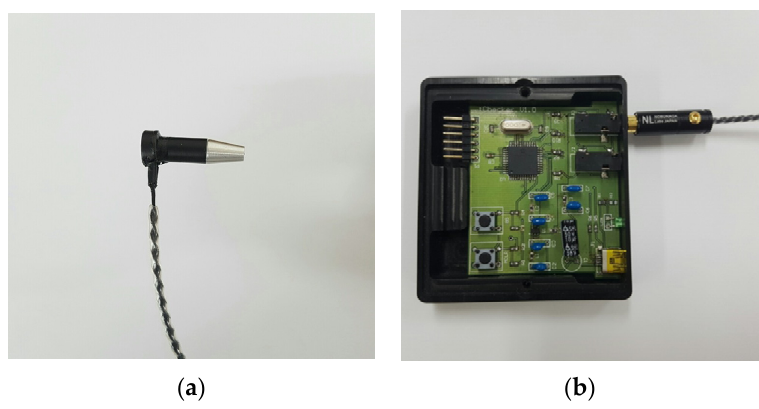
Figure 2. Assembled local system with probe and temperature reader. ( a ) probe; ( b ) temperature reader.